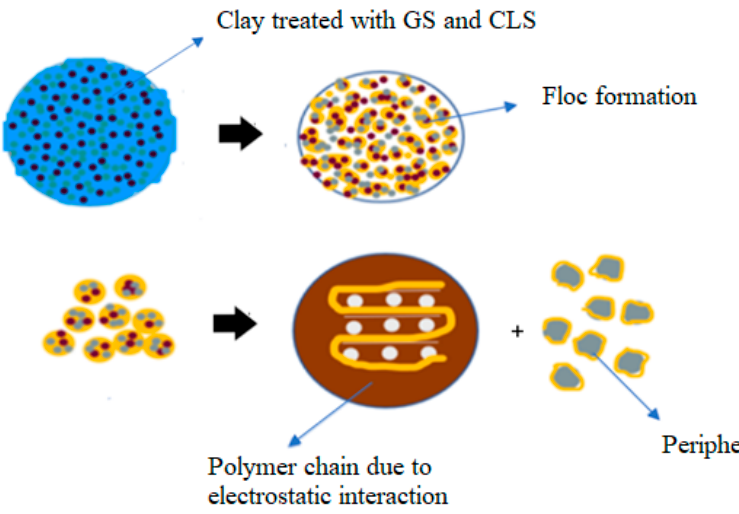
Figure 10. Interaction of CLS with clay and